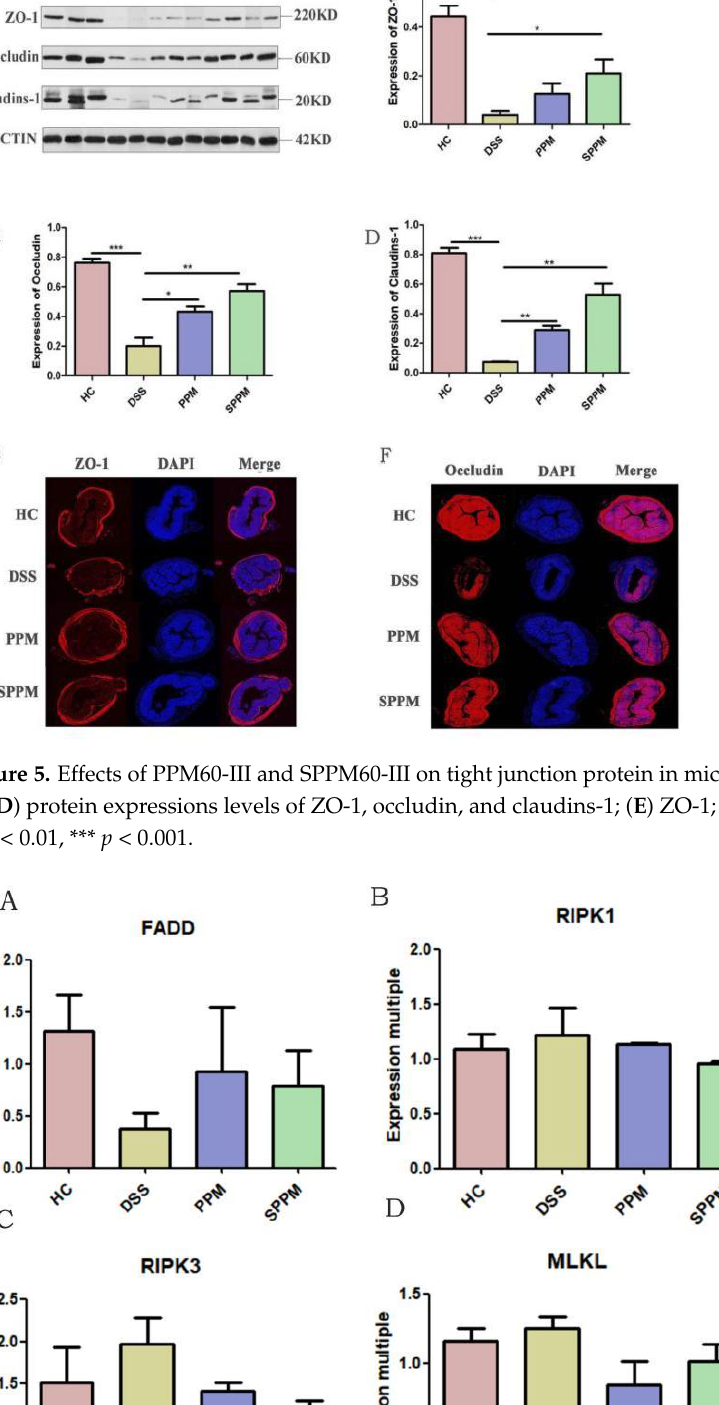
6 of 17 Figure 4. Transmission electron microscopy of tight junctions in mouse colonic tissue. The red arrow points to the microvilli on the epithelial surface of the colon mucosa and the black arrow points to the tight junctions of cells. The integrity of the intestinal mucosal barrier is maintained by tight junction pro- teins, including ZO-1, Occludin, and Claudin-1. Western blotting showed that the protein expressions of ZO-1, Occludin, and Claudin-1 in the DSS group were significantly de- creased compared with the HC group ( p < 0.001), while the protein expressions in the PPM and SPPM groups were restored to different degrees, among which the SPPM group had a better recovery effect and significantly increased the expressions of the ZO-1 ( p < 0.05),